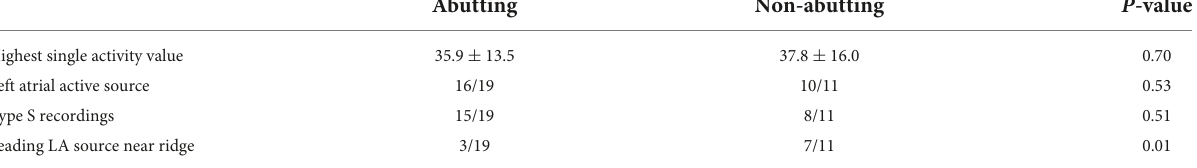
TABLE 4 Electrographic flow data.